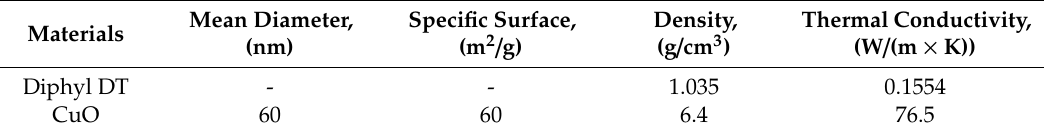
Figure 2. TEM image of CuO (mean diameter: 60 nm). Table 1. Physical properties of the base fluid and CuO nanoparticles.